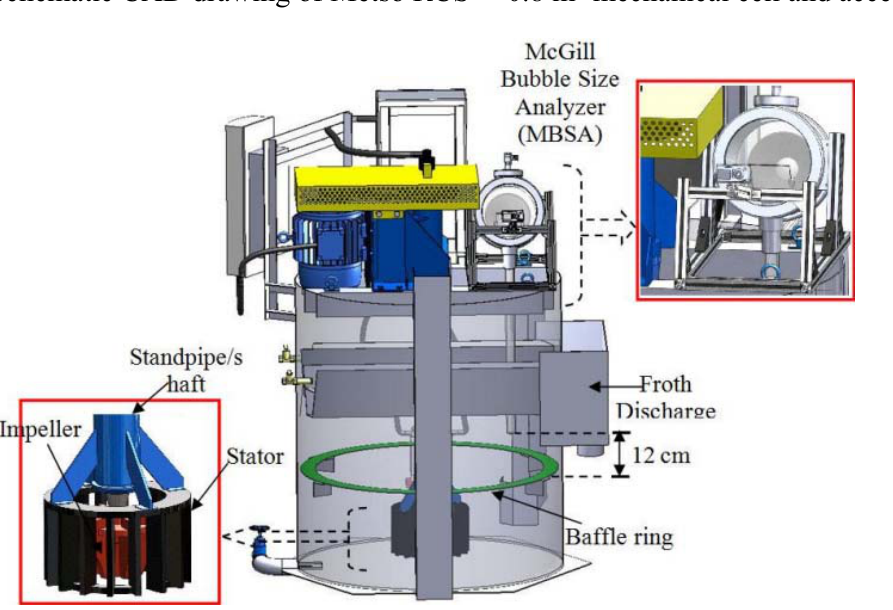
Figure 1. Schematic CAD drawing of Metso RCS TM 0.8 m 3 mechanical cell and